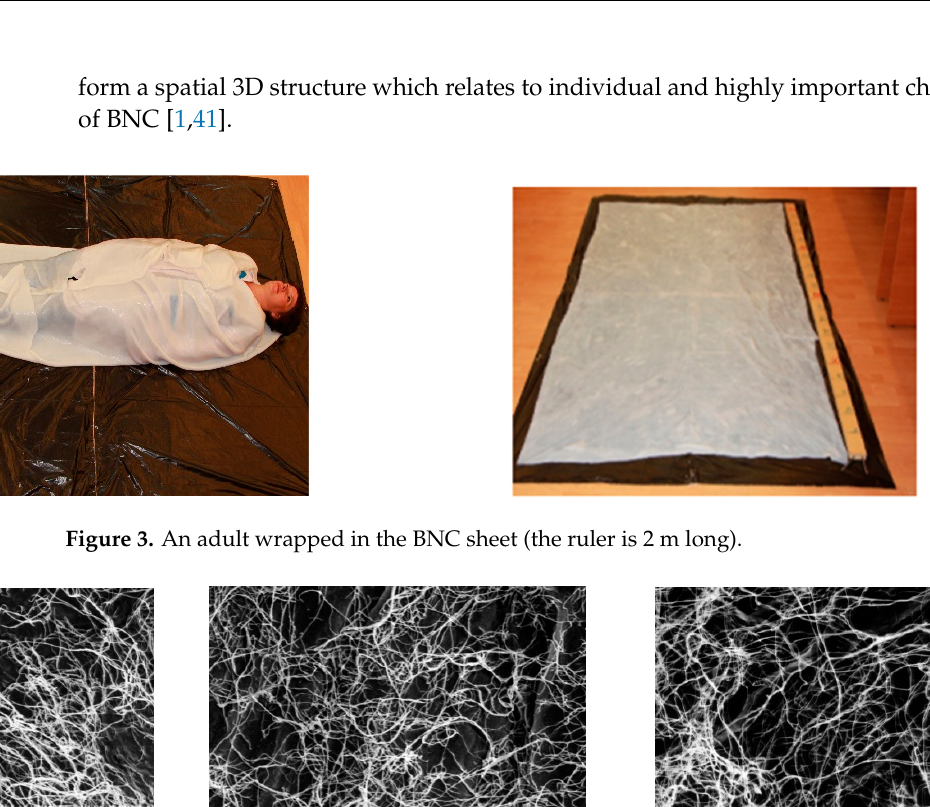
Table 2. Cellulose degree of polymerization, strength characteristics and TGA data for BNC. Characteristic Figure 4. SEM images of BNC: ( а ) Sheet 1, ( b ) Sheet 2/1 and ( c ) Sheet 2/2 at a zoom of ×3000. Table 2 lists cellulose degrees of polymerization, strength behavior and TGA data for BNC. For the all three BNC sheets, the degree of polymerization had high values